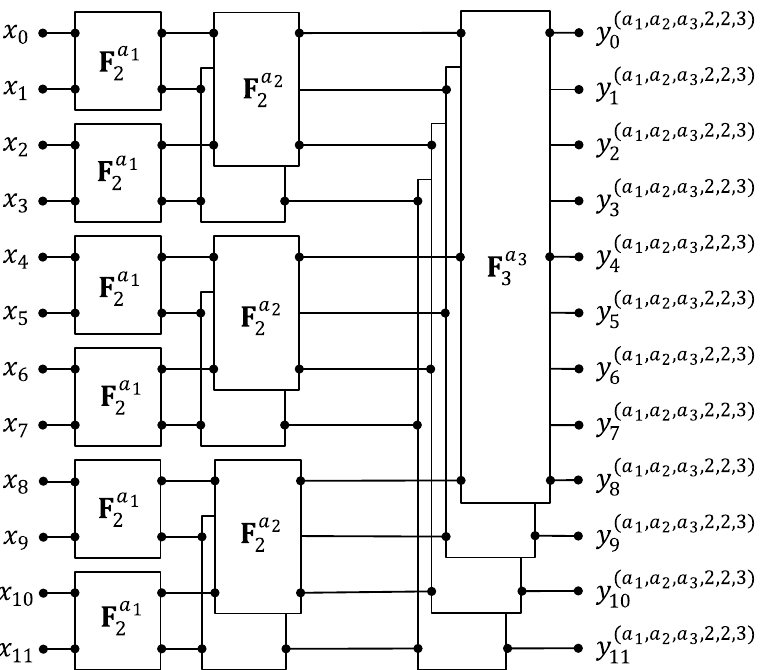
Figure 9. Data flow diagram of the algorithm of multiple-parameter discrete pseudo-fractional Fourier transform for N = 12 = 2 × 2 ×